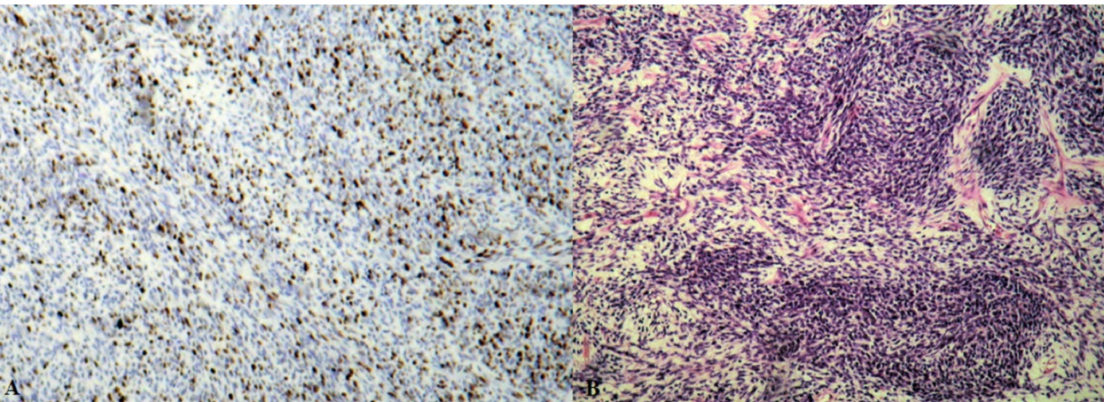
Figure 4. Histopathological findings of the surgical specimen: ( A ): Ki67 immunoreactivity highlights a high-grade sarcoma; ( B ): high-magnification view of the synovial sarcoma; H&E.